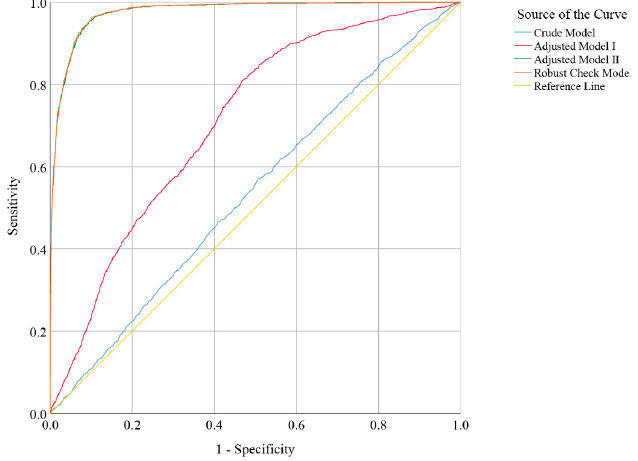
Figure 5. Receiver operator characteristic (ROC) curve indicator of poor RGCS (crude model: without covariates; adjusted model I: gender, age, and race were controlled; adjusted model II: all potential confounders in the study were controlled; robust check model: all potential confounders in the study were controlled, and the years fixed effect in the study was included).